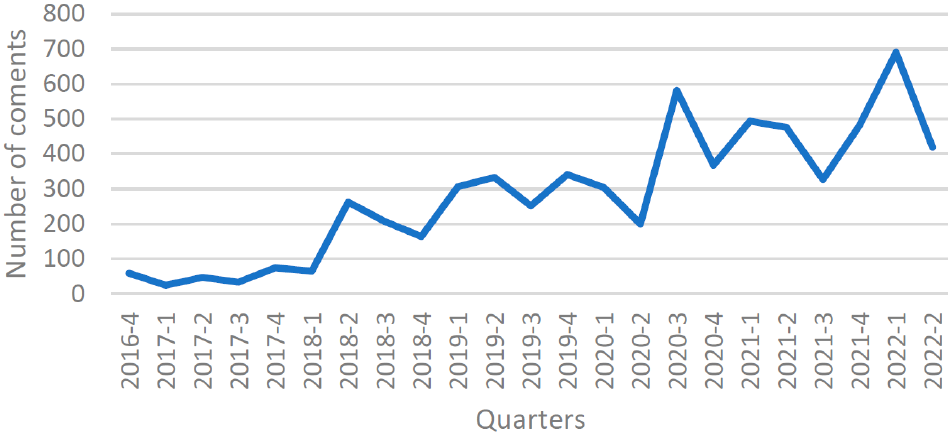
Figure 4. The number of users’ comments by quarters.